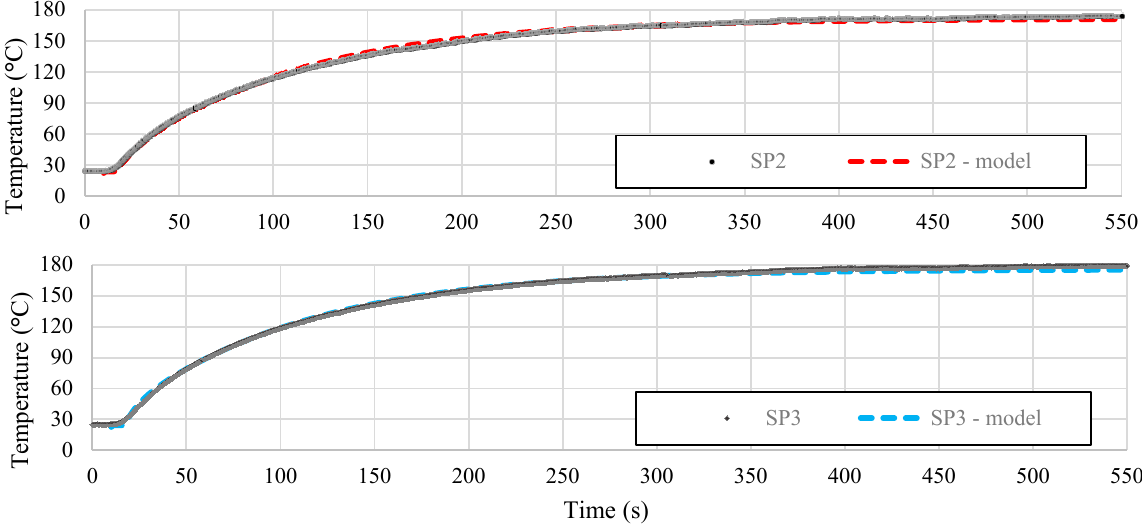
Figure 10. The simulation results converge to the experimental ones—PCB test points SP1–SP3 for the output power P out = 700 W.